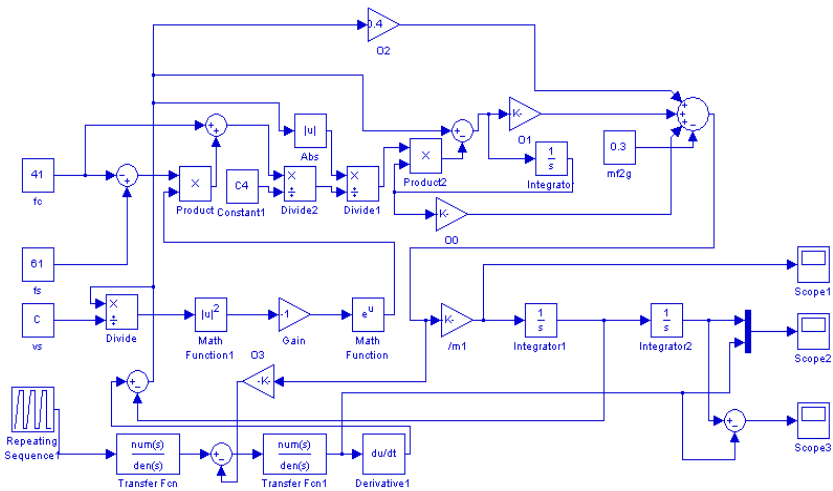
Figure 7. Simulation model the PASSNS. Reproduced with permission from